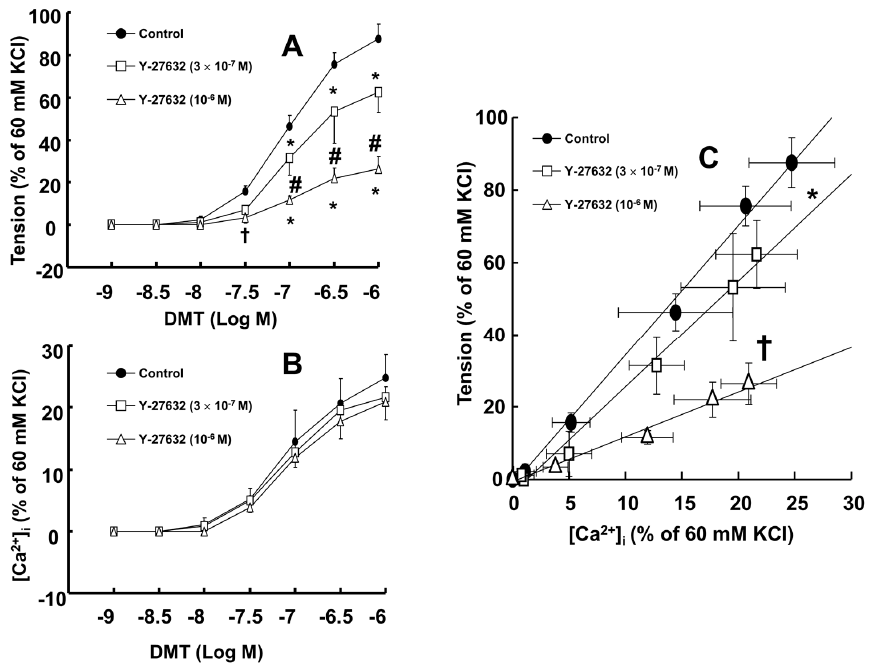
Figure 2. Effects of the cumulative addition of dexmedetomidine (DMT, 10 − 9 to 10 − 6 M) on muscle tension ( A ) and intracellular calcium concentrations ([Ca 2+ ] i ) ( B ) in the absence or presence of 3 × 10 − 7 M or 10 − 6 M Y-27632 in endothelium-denuded rat aortas. A value of 100% represents the 60 mM KCl-induced [Ca 2+ ] i increase and muscle tension measured before washout with Krebs solution; ( C ) The [Ca 2+ ] i -tension relationship was constructed by measurements of the cumulative addition of DMT (10 − 9 to 10 − 6 M) in the absence or presence of Y-27632. Each point represents the mean of five experiments, and the standard deviation (SD) is shown by both the vertical and horizontal bars. The effects of Y-27632 on the DMT concentration-response curves were analyzed using two-way repeated measures analysis of variance (ANOVA) followed by Bonferroni’s post hoc test. The slopes of the [Ca 2+ ] i -tension curves induced by DMT were calculated using linear regression, and the effect of Y-27632 on the slope was analyzed using one-way ANOVA followed by Bonferroni’s post hoc test. ( A , B ): * p < 0.001 and † p < 0.01 versus control. # p < 0.001 versus 3 × 10 − 7 M Y-27632; ( C ): slope; * p < 0.05 and † p < 0.001 versus control.